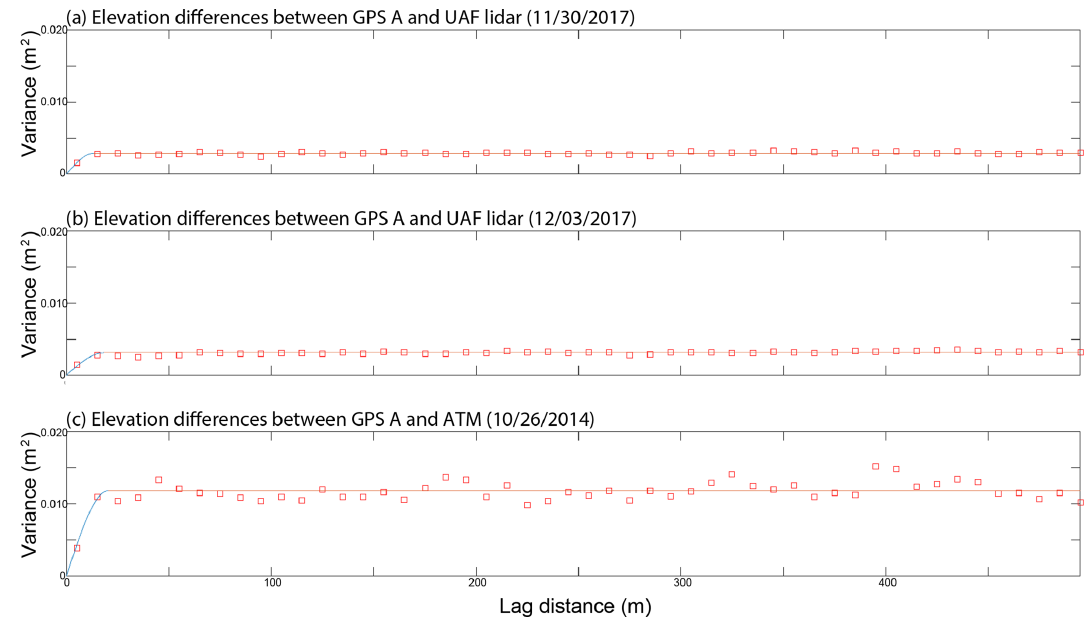
Figure 7. Semivariograms of elevation differences between GPS unit B and elevations derived from ATM (a) and the UAF lidar on 30 Novem- ber 2017 (b) and 3 December 2017 (c) . The x axes are lag distances between the observations, in meters, and the y axes are variance, in square meters. The red squares are the observed elevation differences in 50m bins and the lines represent a semivariogram model fit to these